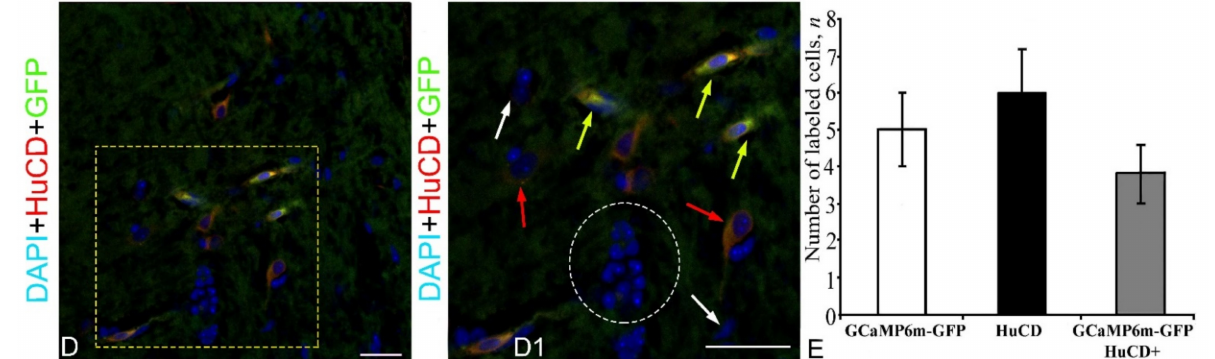
Figure 6. Z-stacks showing DAPI staining, localization of green fluorescent protein GFP and HuCD, and their colocalization in the latero-caudal region of the tectum in juvenile chum salmon, O. keta , at 90 days after a single injection of the rAAV into the cerebellar body. ( A ) DAPI staining with a pictogram showing the latero-caudal region of the tectum in a red box; the white box outlines an accumulation of DAPI-stained nuclei in the tectum; ML, molecular layer. ( A1 ) The enlarged fragment in A; white dotted line outlines a cluster of nuclei; DAPI+ single nuclei (white arrows). ( B ) Expression of the green fluorescent protein GFP in bipolar neurons (dashed yellow box). ( B1 ) The enlarged frag- ment outlined by a yellow dotted box in B; GFP+ neurons (green arrows). ( C ) Immunofluorescence of the HuCD protein in neuronal populations of stratum grizerum centrale (SGC) and stratum grizerum et album periventriculare (SGAP). ( C1 ) The enlarged fragment outlined by a red dotted box in C; HuCD+ neurons (red arrows). ( D ) Optical overlay of three DAPI, GFP; HuCD channels showing areas of GFP/HuCD co-localization in neurons (dashed yellow box). ( D1 ) The enlarged fragment outlined by yellow dotted box in D; neurons with GFP and HuCD co-localization (yellow arrows), DAPI-stained nuclei (white arrows), HuCD+ neurons (red arrows), and a cluster of nuclei (outlined by white dotted oval). Laser scanning confocal microscopy. Scale bar: ( A , B , C , D ) 50 µ m; ( A1 , B1 , C1 , D1 ) 20 µ m. ( E ) One-way ANOVA showing the relative distribution of GFP and HuCD immunolabeled